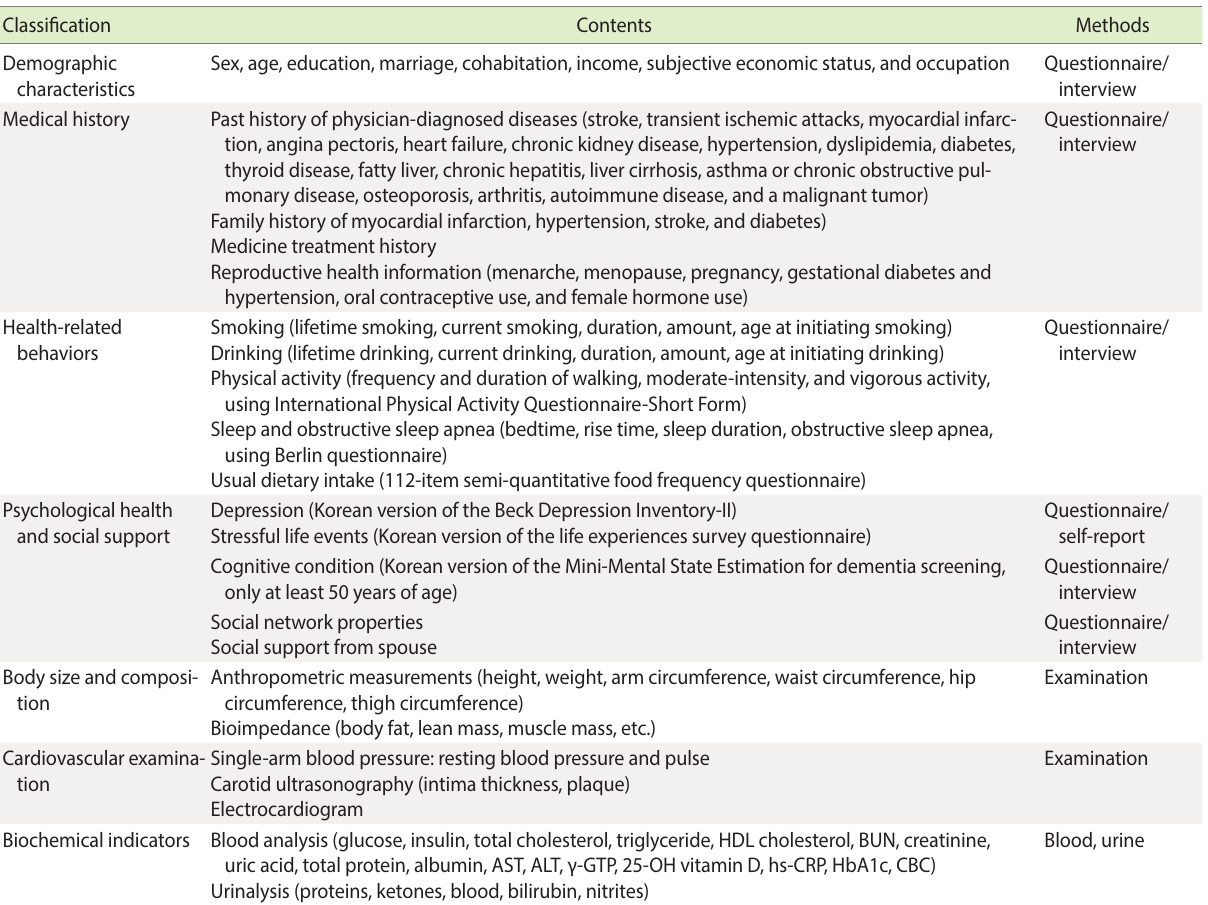
Table 3. Common elements of the baseline assessment at both